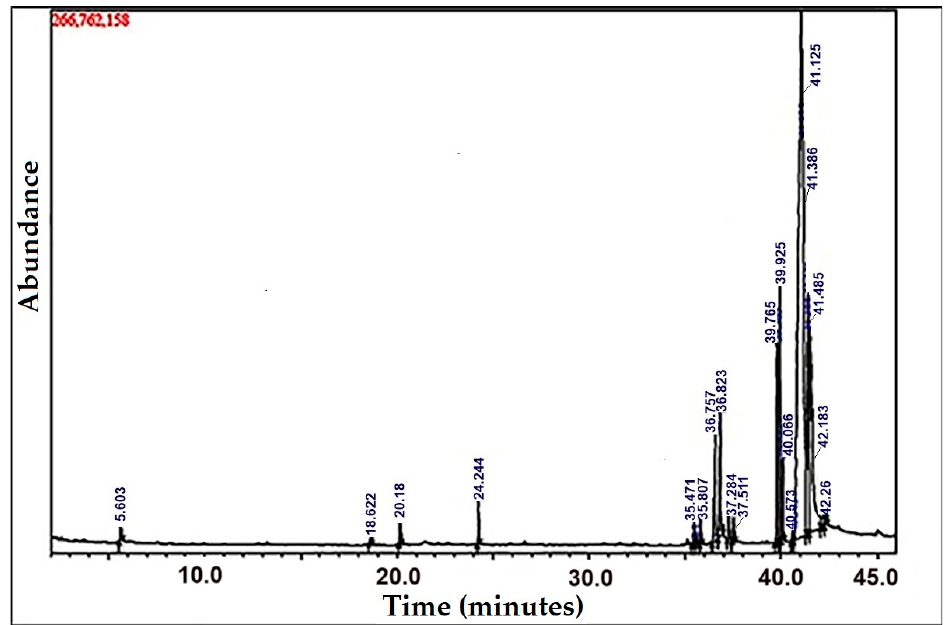
Figure 1. GC–MS chromatogram of the ethanol extract of Nigella sativa seeds. Table 1. Retention time, phytochemical compounds, and peak area % determined by GC–MS analysis of Nigella sativa seed extract.